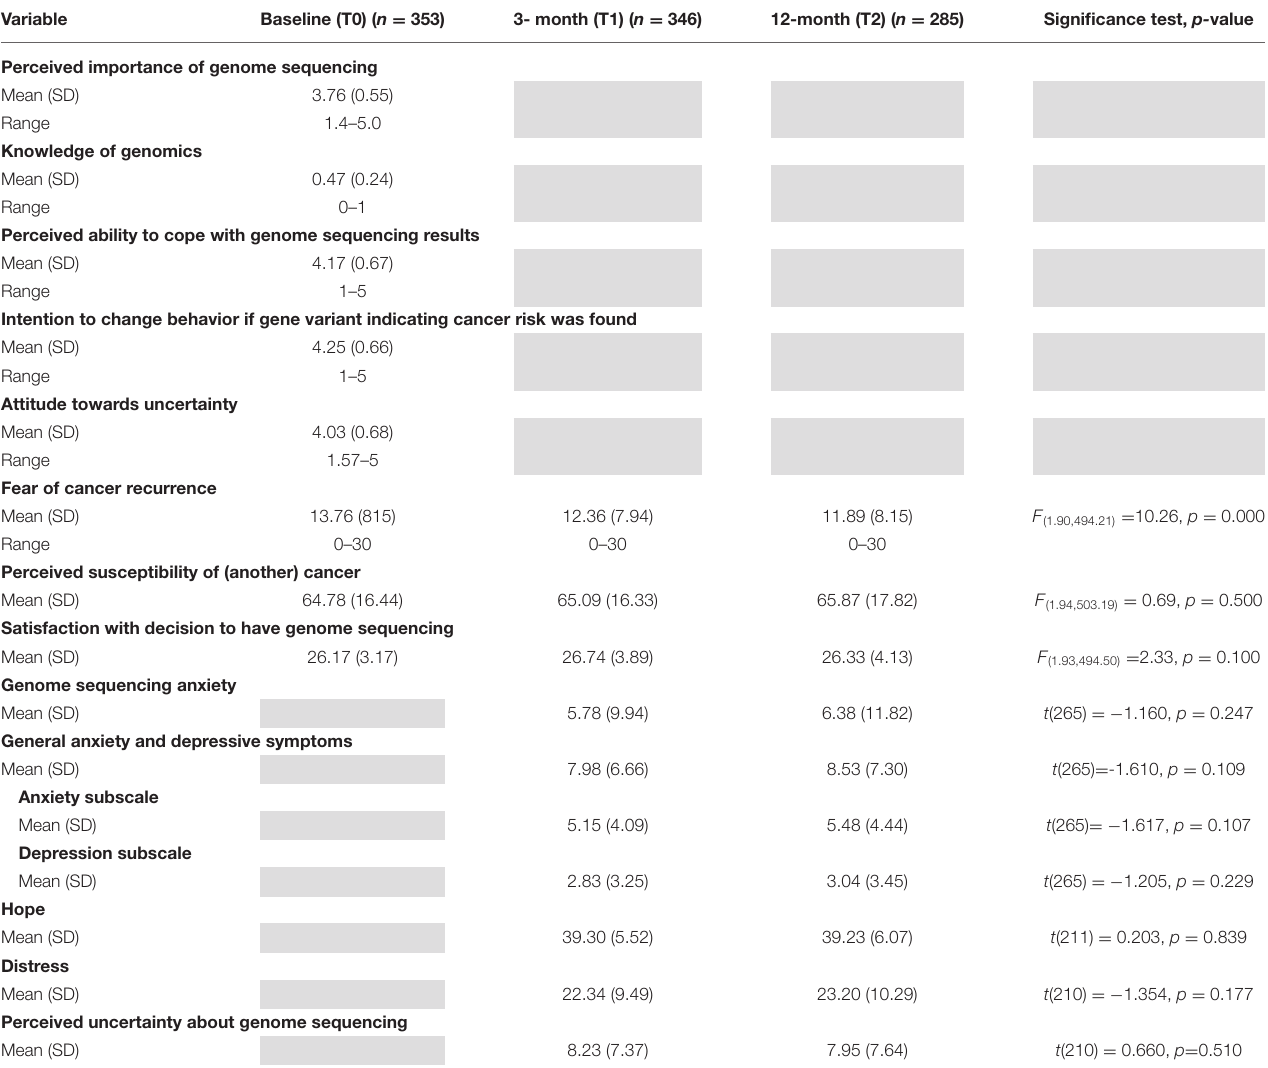
TABLE 3 | PiGeOn participants’ knowledge, attitude, and psychological outcomes over 12 months.